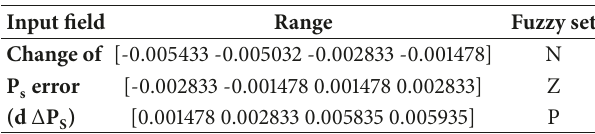
Table 5: MFs of change in Δ P s .